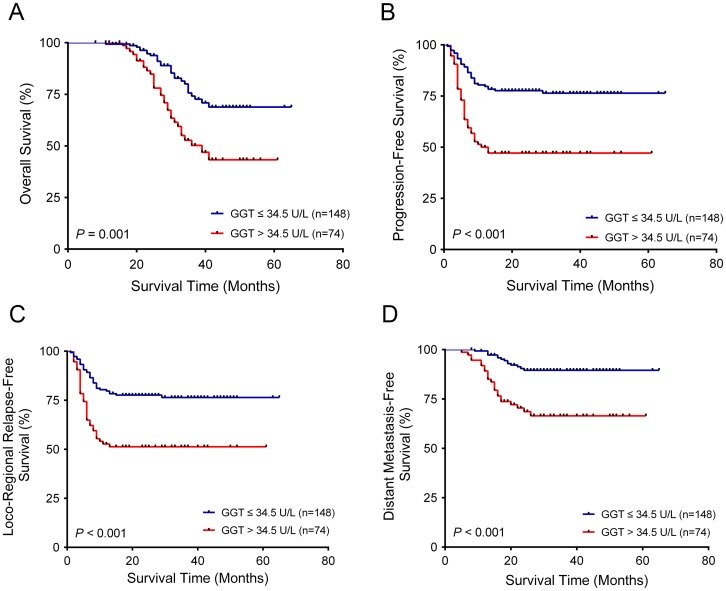
Kaplan–Meier curves for OS, PFS, LRRFS and DMFS regarding the pretherapeutic serum level of GGT.Kaplan-Meier survival estimates and log-rank tests were used to analyze the prognostic significance of GGT in all patients. (a) OS; (b) PFS; (c) LRRFS; (d) DMFS.